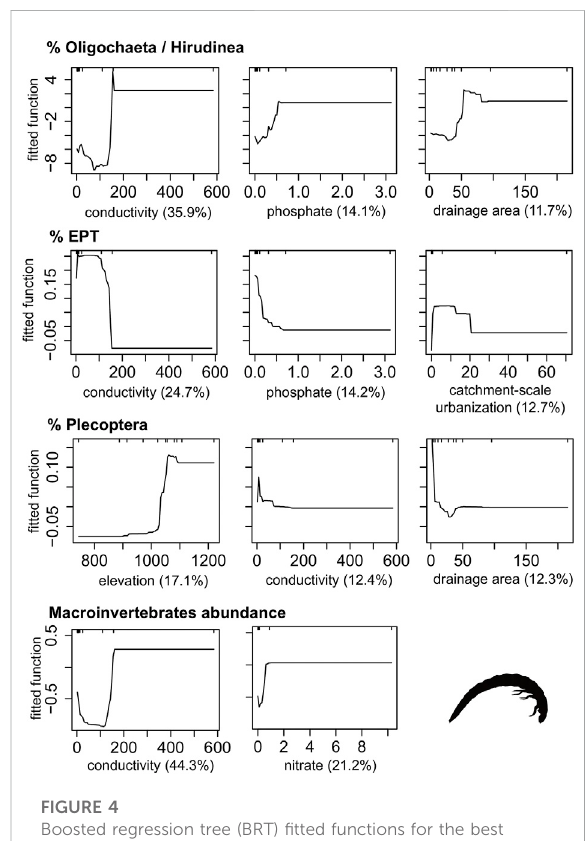
FIGURE 4 Boosted regression tree (BRT) fi tted functions for the best performance models of Macroinvertebrate metrics. Plots are only shownforthosepredictorsthatexplainedmorethan10%deviance in the metric. Rug plots show the distribution of data, in deciles, of the variable on the X-axis.